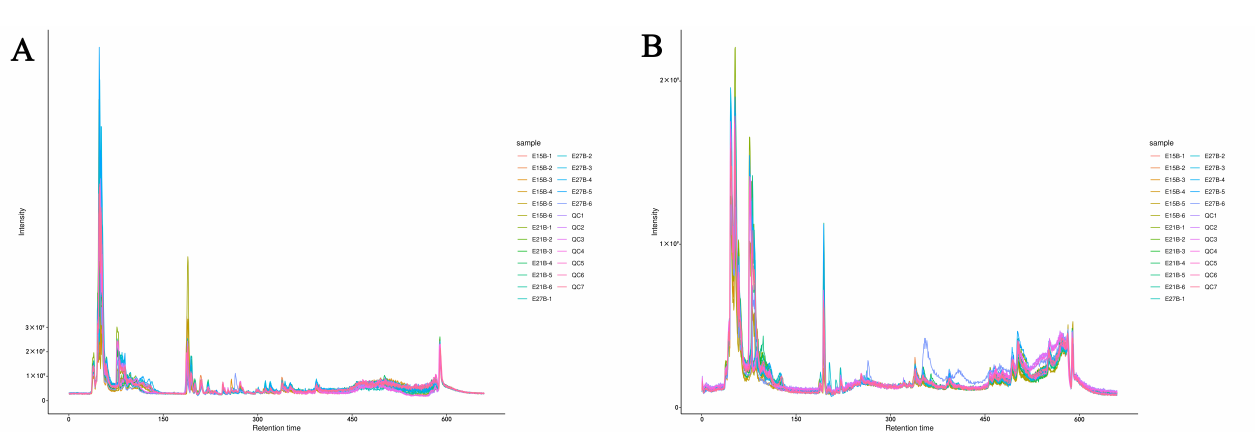
Figure 1. Overlapping analysis of total ion chromatogram. ( A ) The electrospray ionization positive ion mode (pos); ( B ) the electrospray ionization negative ion mode